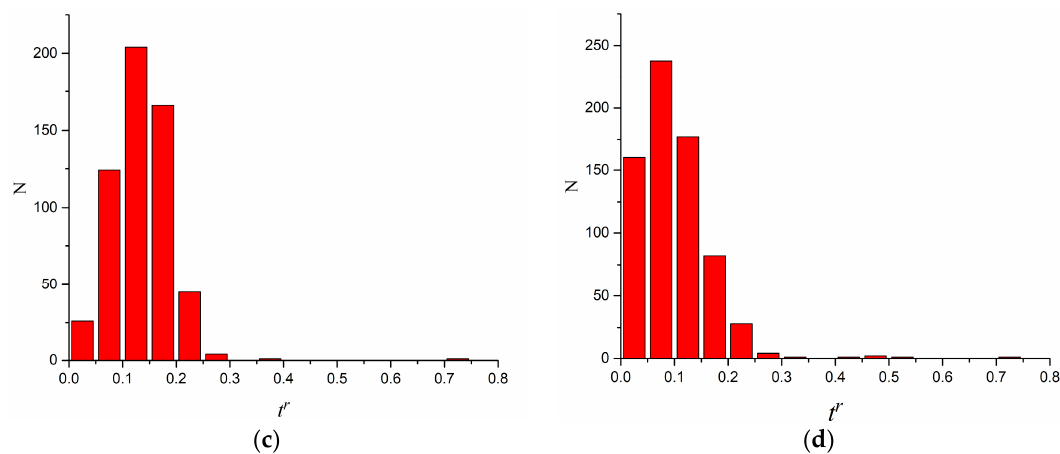
r t for alloys for alloys VT23 i i